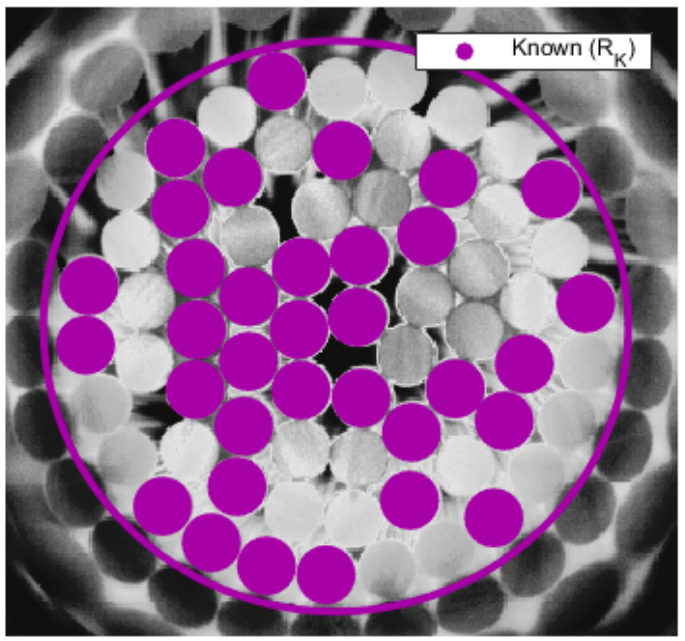
Figure 6. IR images of randomly packed rod assembly with locations of rods with known tempera- tures indicated in